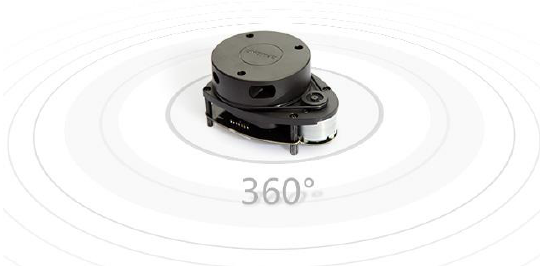
Figure 3. RPLIDAR A1M8 (2D rotating laser scanner).